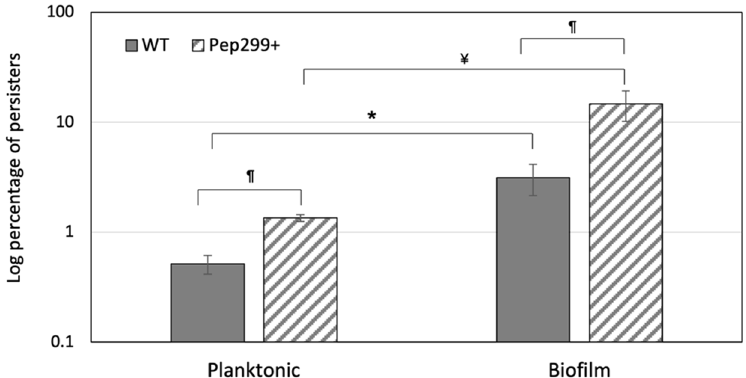
Figure 3. Formation of persisters by biofilm and planktonic cells. Static biofilms were developed using a microtiter plate. The biofilm and planktonic cells were treated for 24 h with ofloxacin to kill all nonpersisters. Aliquots of cells were removed at the introduction of the antibiotic (T = 0) and after the antibiotic treatment (T = 24). Cells were washed with PBS, serially diluted, and spot-plated onto THYE agar for CFU determination. The data (normalized to T = 0) are the average of three independent experiments ± standard error. ¶ denotes statistically significant difference between Pep299+ and WT under the same conditions. * denotes statistically significant difference between WT biofilm and WT planktonic. ¥ denotes statistically significant difference between Pep299+ biofilm vs. Pep299+